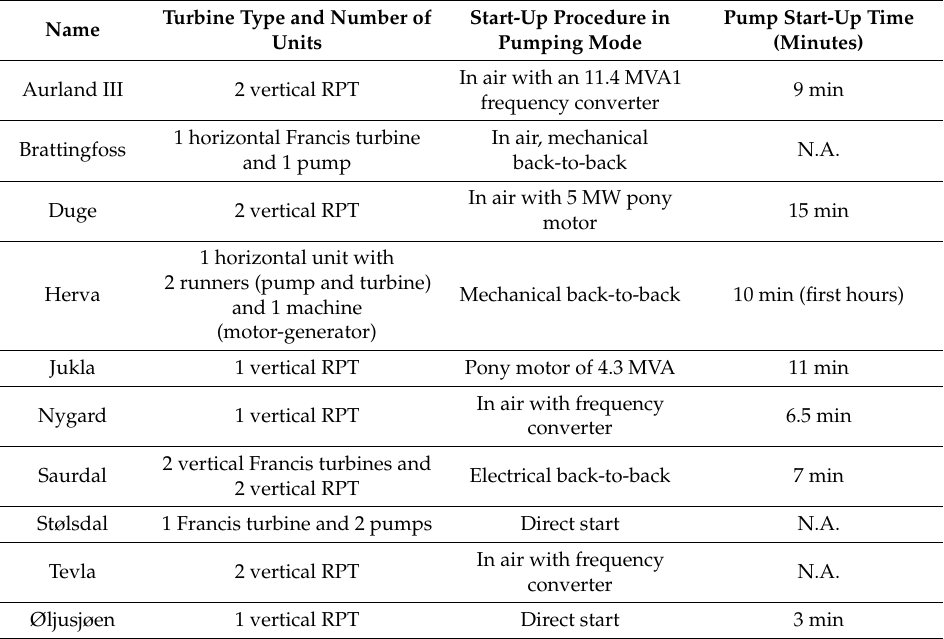
Table 4. Overview of mechanical equipment in Norwegian PSPs.